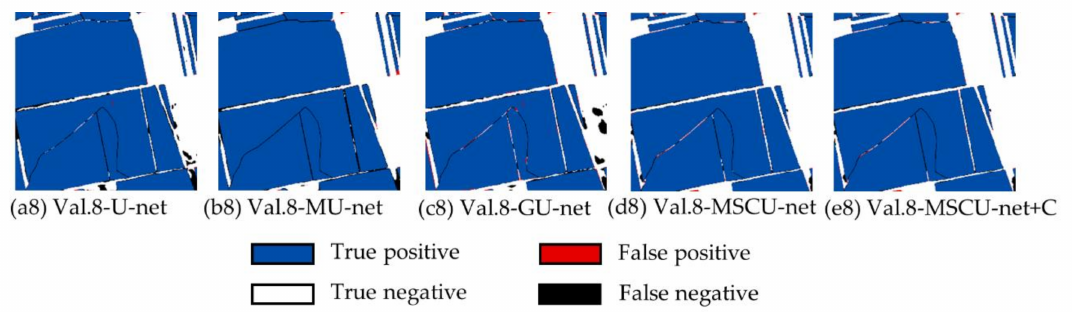
Figure 7. Classification results of ablation experiments using eight validation